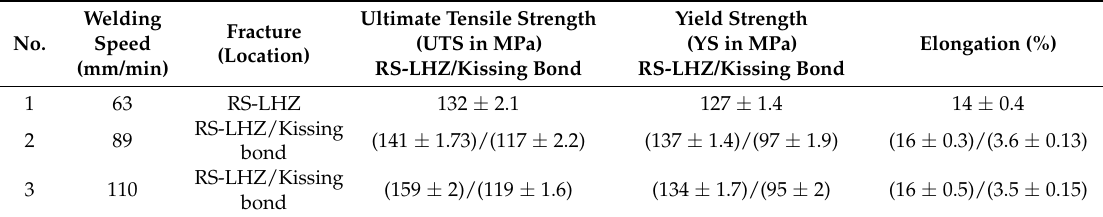
Table 6. Mechanical properties obtained by tensile tests (average).